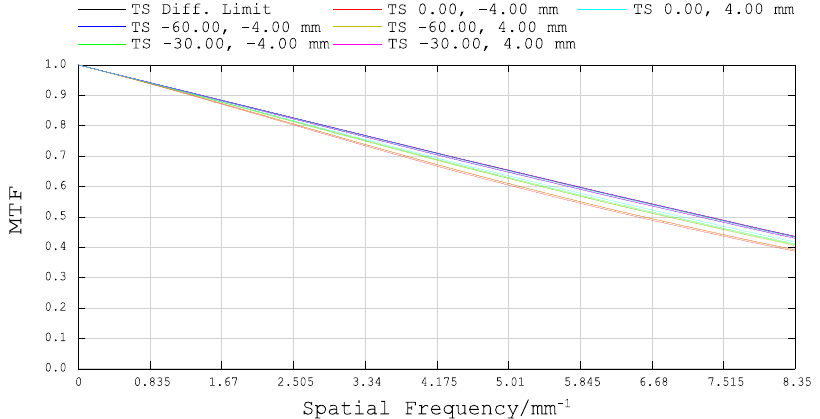
Figure 8. MTF curves for the fields (( − 60 mm, − 4 mm), ( − 30 mm, − 4 mm), (0 mm, − 4 mm), ( − 60 mm, 4 mm), ( − 30 mm, 4 mm), and (0 mm, 4 mm)) along the slit for the central wavelength of 10 μm .